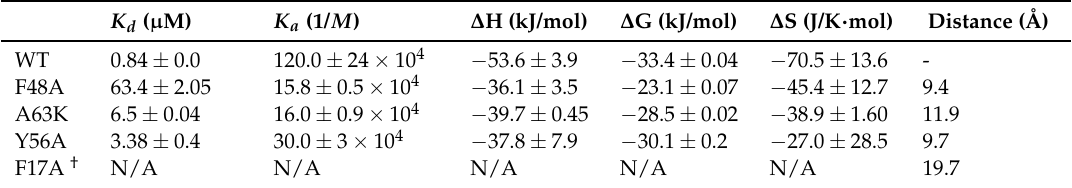
Table 1. Mutations to residues far away from BH3 domain binding site impact vBcl2 function. † refers to the mutation that destabilizes the protein (see text below) and, hence, no Isothermal Titration Calorimetry (ITC) measurements are